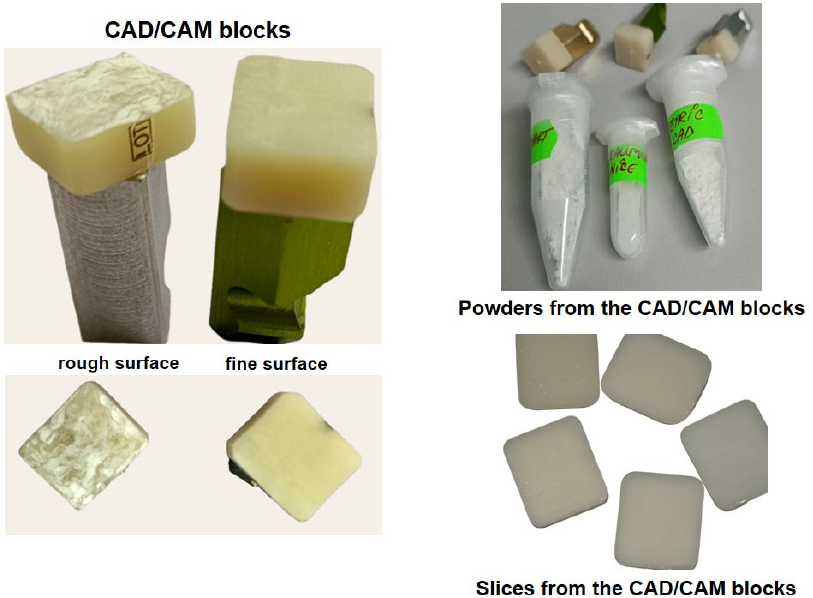
Figure 1. CAD/CAM blocks with rough and fine surfaces, as well as powders and slices obtained.